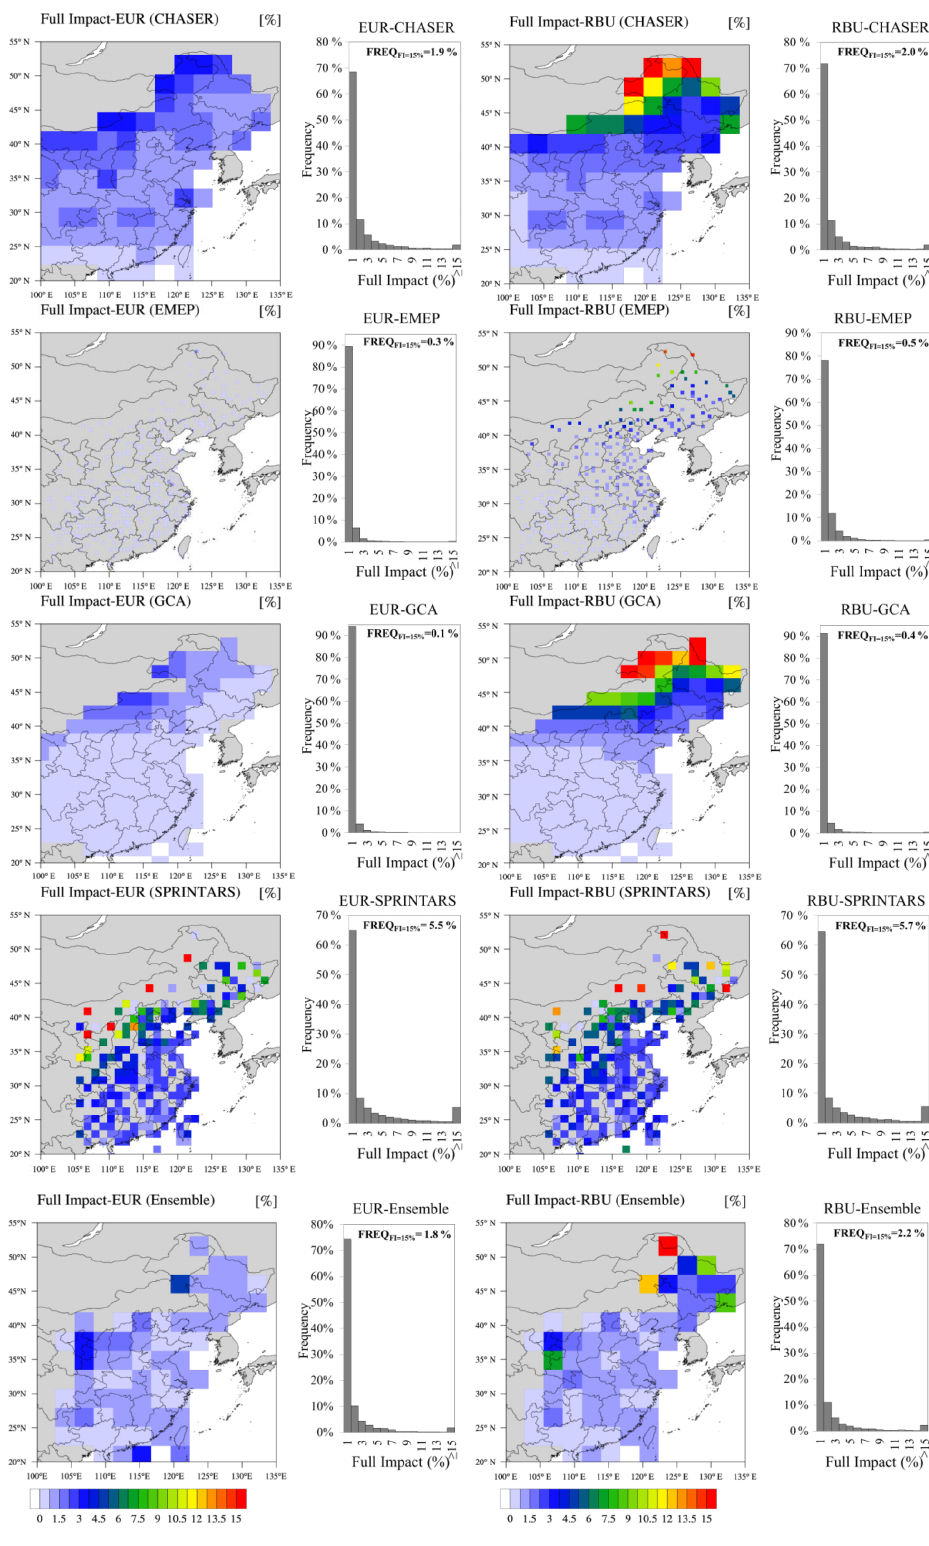
Figure 9. Spatial distributions and histograms of the full impacts of long-range transport during the haze episodes. Model grids with no NCDC observation sites are assigned to fill